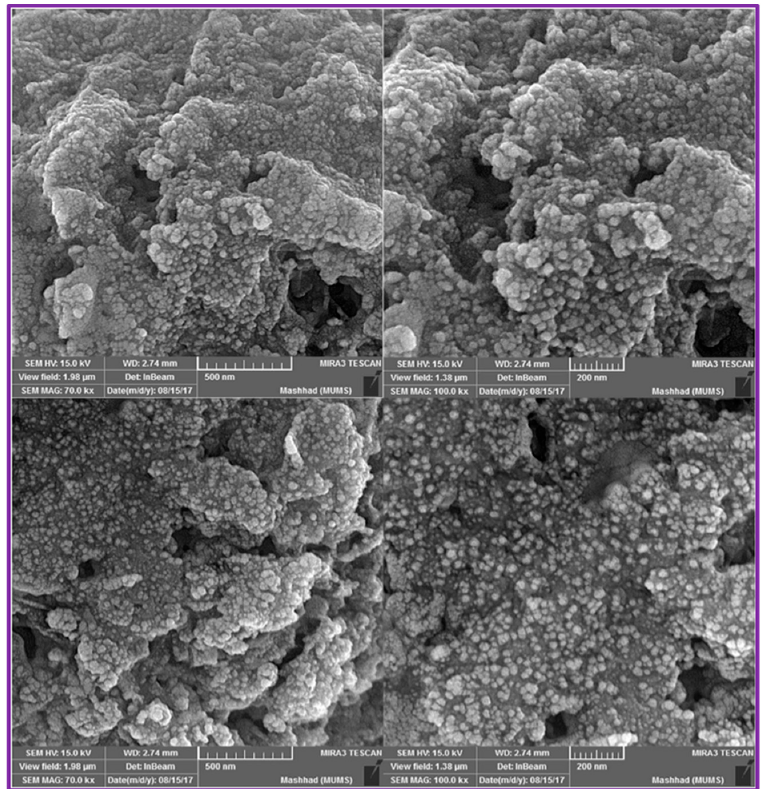
Figure 1. SEM images of carbon dots with different sizes. Reproduced with permission from ref. [33]. Zhu et al. decomposed alkali lignin (AL) to GCD through hydrothermal method. As part of the process, the AL were hydrolyzed in presence of mild organic acids (e.g., 4- aminobenzoic acid, benzenesulphonic acid, 4-aminobenzenesulphonic acid, 2,4-diamino- benzenesulphonic acid) before the hydrothermal treatment. These GCDs showed stability in a wide pH range (3–11). They also exhibited yellowish green fluorescence below pH 7 due to the protonation, and green due to deprotonation in basic medium [7]. The emission property also changed with respect to the sizes of the GCDs as shown in Figure 2.